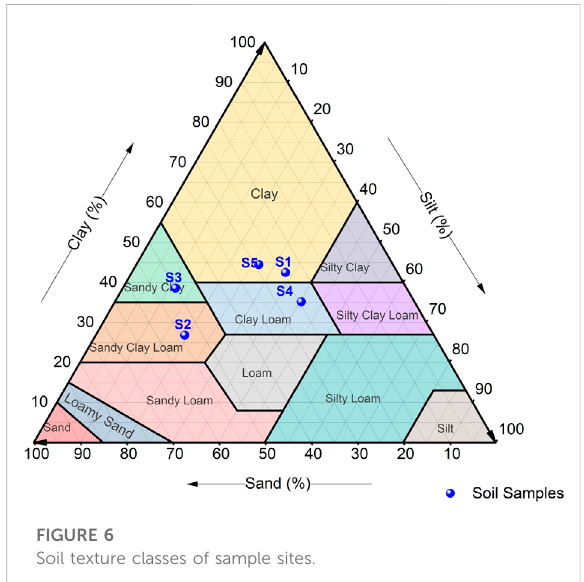
FIGURE 6 Soil texture classes of sample